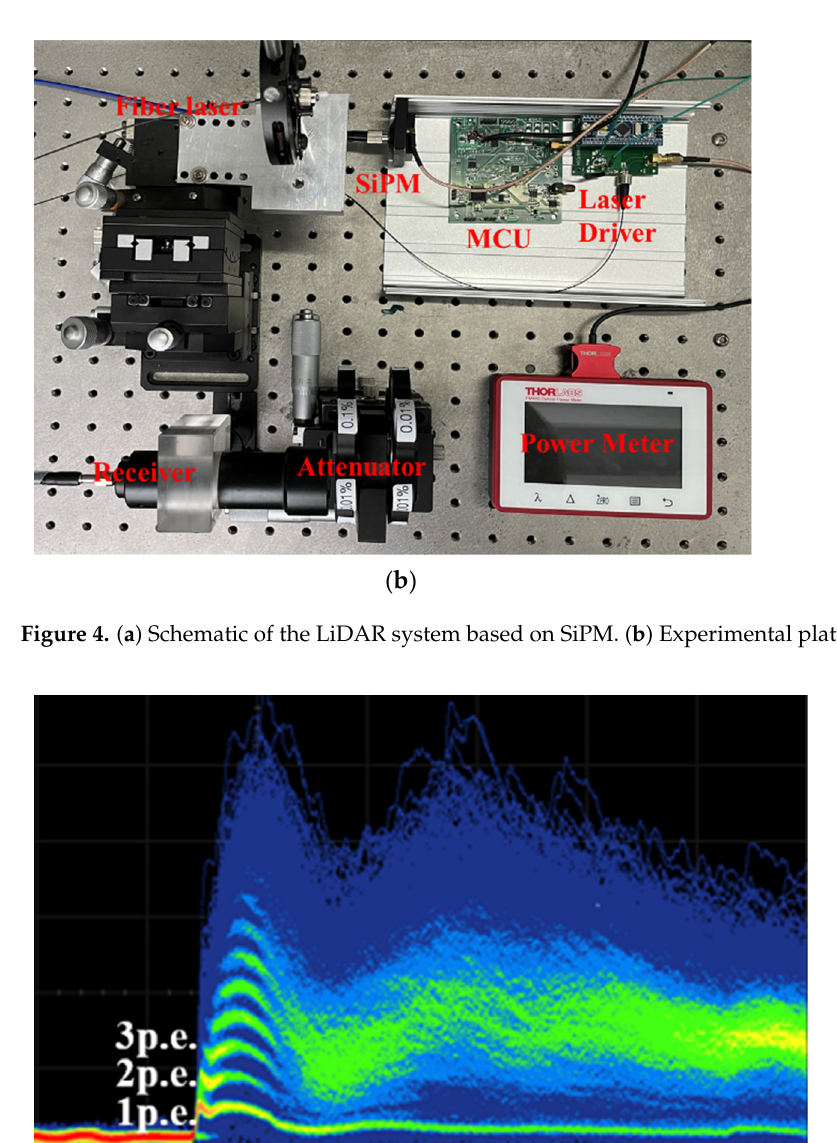
Figure 4. ( a ) Schematic of the LiDAR system based on SiPM. ( b ) Experimental platform.